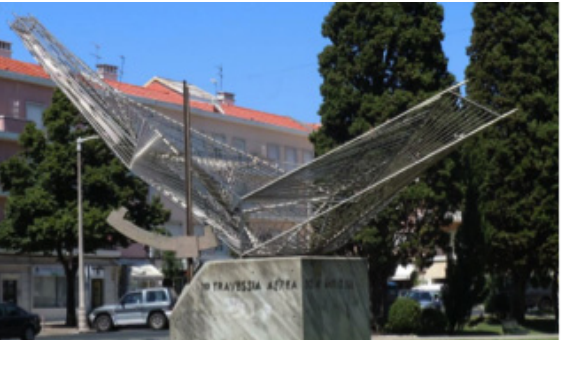
FIGURE 15 | L. Santos, Air Crossing , 1972.